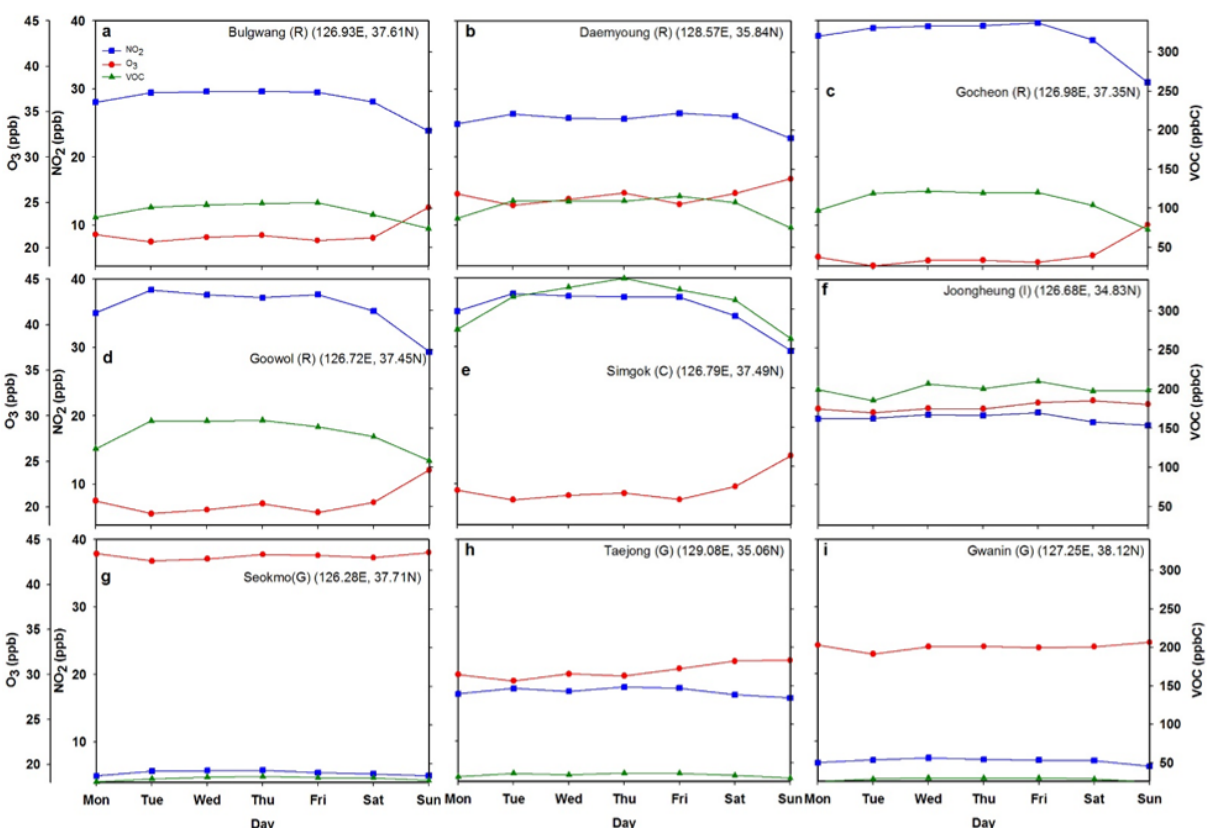
Figure 10. The weekly variations in the VOCs (green triangle), O 3 (red circle), and NO 2 (blue rectangle) concentrations at the nine pho- tochemical air pollution monitoring stations in South Korea since 2007 under the MEK four land-use types as follows: residence (R), commerce (C), industry (I), and greenbelt (G). Please see Table 2 for the observational period at each of the VOC stations. For convenience, the terminology of “VOC” in the figures means “VOCs” in the text. Table 11. The spatial mean values of the long-term surface air pollutant concentration averages (O 3 , NO 2 , OX, VOC, and VOC / NO 2 ) at nine of the photochemical air pollution monitoring stations of the MEK over South Korea since 2007 in terms of the four MEK land-use categories as follows: residence (R), commerce (C), industry (I), and greenbelt (G). Air pollutant Residence Commerce Industry Greenbelt Average O 3